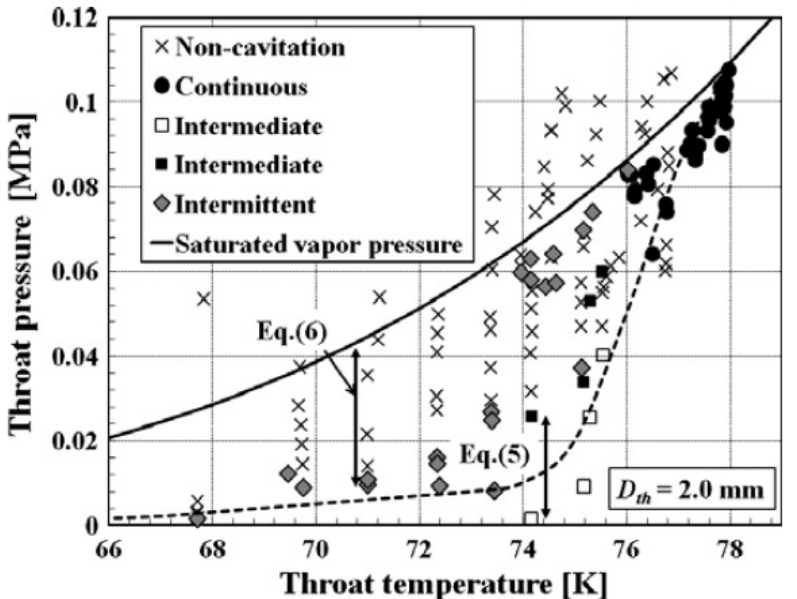
Figure 8. Map of the flow conditions, i.e., fully-liquid or cavitation, in liquid nitrogen in terms of the measured pressure and temperature at the nozzle throat. Different symbols distinguish the cavitation behavior: circles stand for continuous cavitation, squares for intermediate, and diamonds for intermittent cavitation [78]. Reprinted from [78], Copyright (2012), with permission from